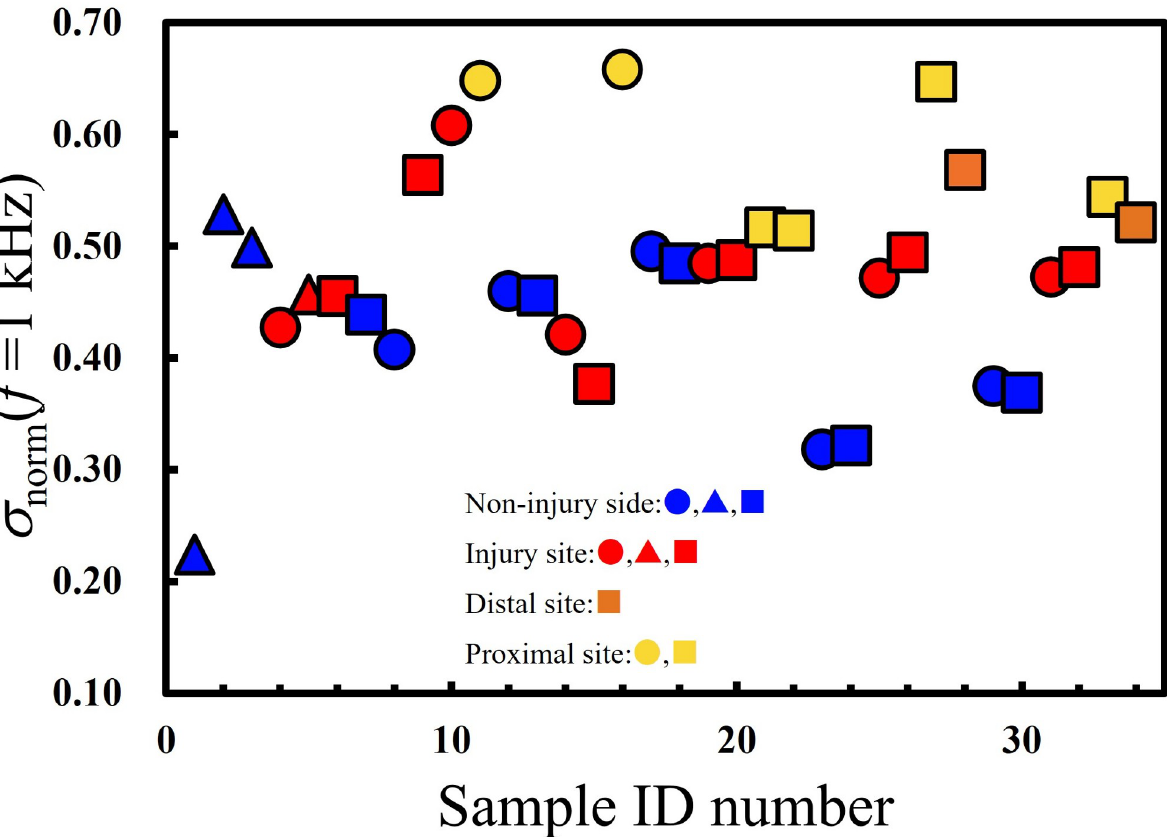
Fig 9. Plots of σ at 1 kHz normalized by σ ( f = 1.6 MHz) of the nerves. The shapes of the plots indicate the applied voltage as 0.1 V (circles), 0.5 V (squares), and 1.0 V (triangles).